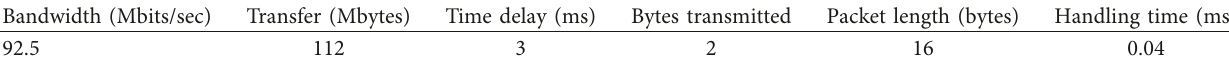
Table 3: Parameters and results of the control transmission experiment.